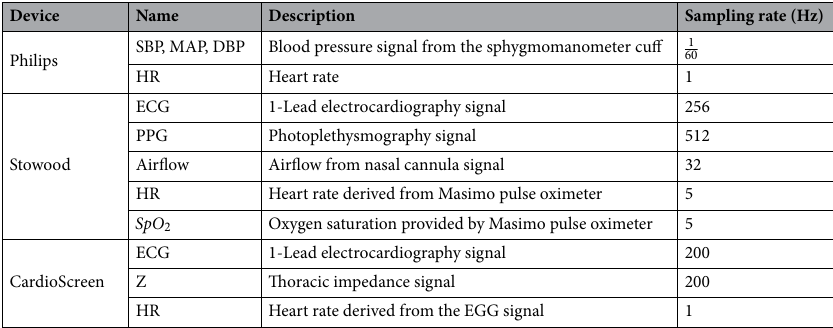
Table 4. Physiological parameters and sampling rates recorded by the 3 devices used in this study.